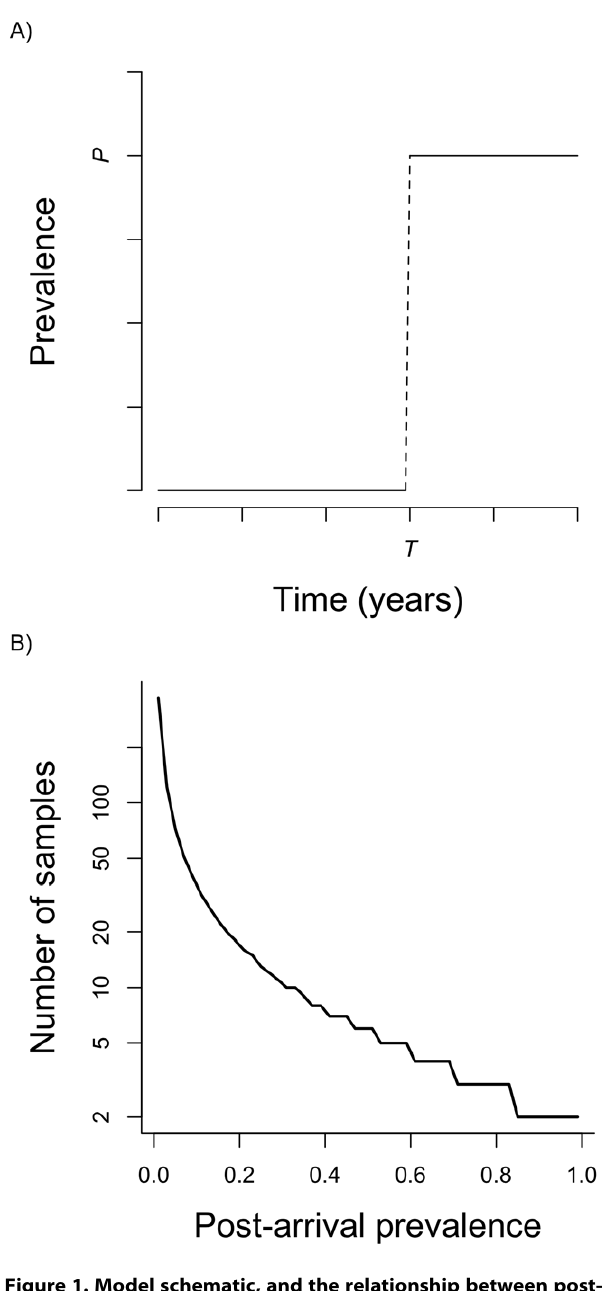
Figure 1. Model schematic, and the relationship between post- arrival prevalence and minimum adequate pre-arrival sample size. A) Schematic of the statistical model used to estimate the arrival time of chytrid. The model is a threshold where the prevalence of infection is zero up until some time, T , at which point the prevalence jumps to some new, average value, P . B) The approximate number of samples from a population with prevalence of zero required to provide a lower (2.5 th percentile) bound on the time of arrival ( T ) parameter in our model. The number of samples required scales with the post-arrival prevalence ( P ). This curve was generated by solving for the number of samples with zero positives required to reduce the binomial probability of that outcome below 0.025, given the stated prevalence.